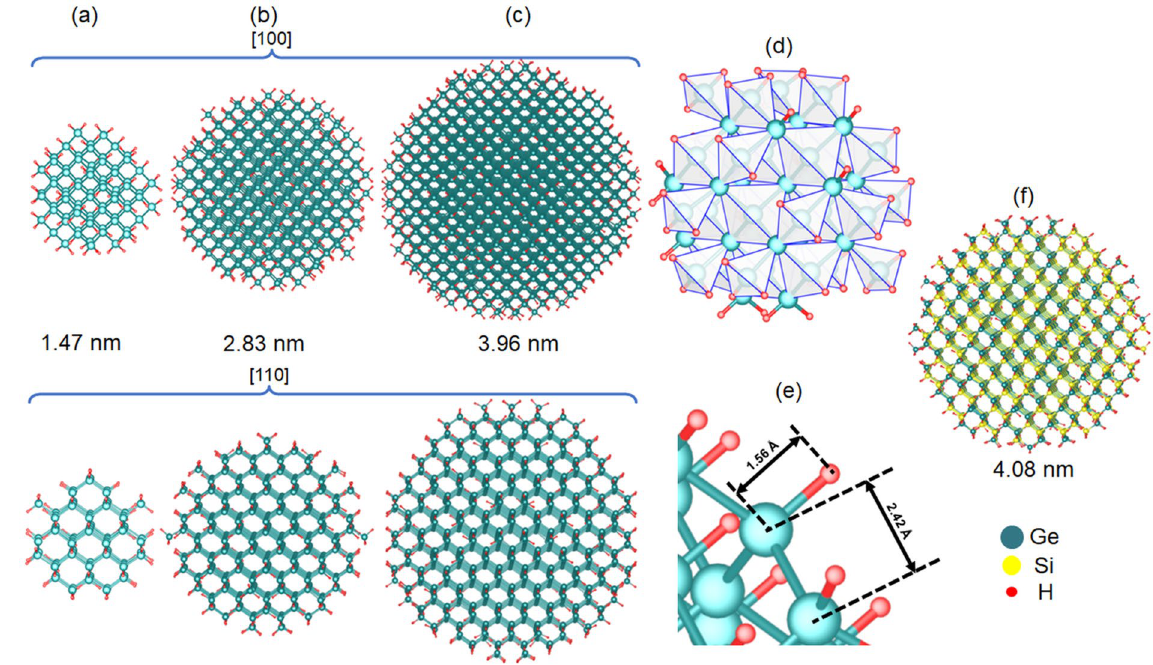
Figure 1. ( a – e ) Relaxed Ge:H NC model in atomistic simulations: ( a ) small (1.47 nm diameter), ( b ) medium (2.83 nm) and ( c ) big NCs (3.96 nm); ( d ) atomic coordinates based on Ge tetrahedral symmetry; ( e ) surface detail of relaxed Ge:H NC. ( f ) Model for relaxed GeSi:H NC with 50:50 Ge:Si composition. Models are produced by VESTA 41 .